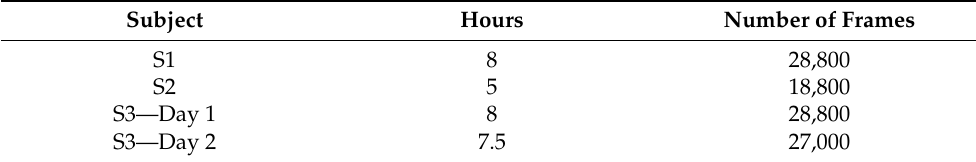
Table 6. YouTube dataset summary.